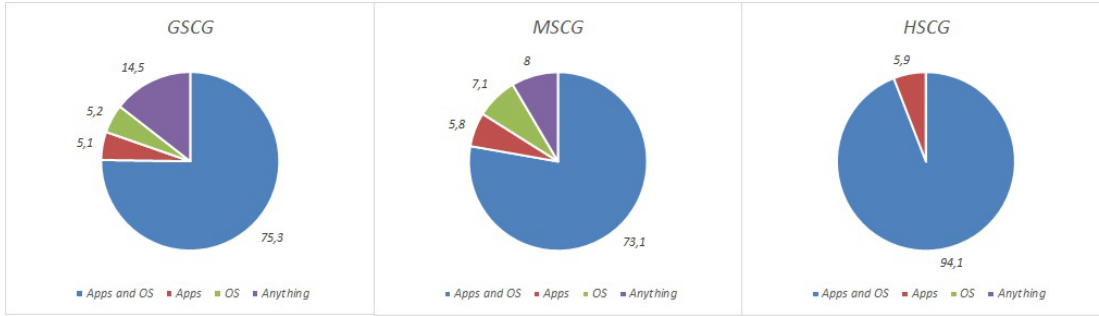
Figure 3. Do you regularly update the software on your mobile device? (laptop).